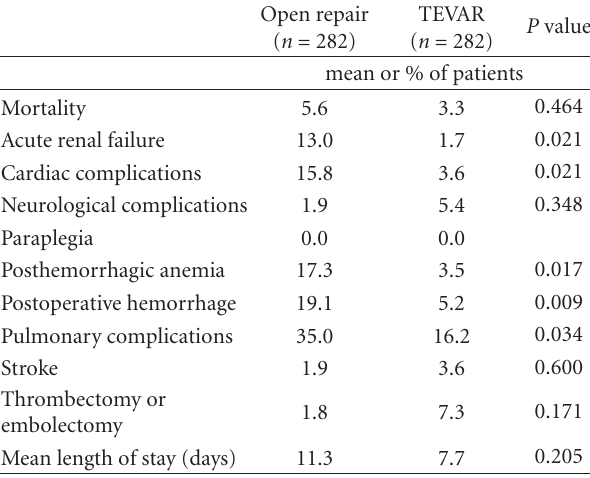
Table 5: In-hospital outcomes after open repair or TEVAR in a matched cohort of electively admitted patients.